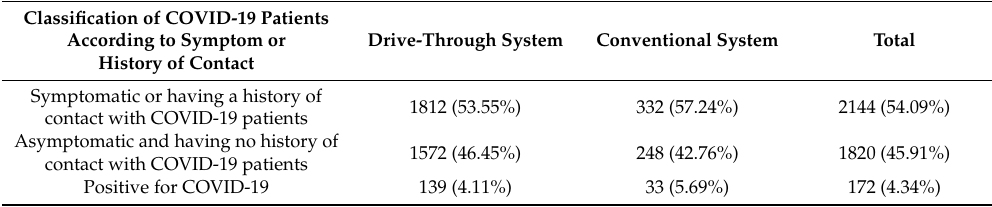
Table 4. The number of SARS-CoV-2-positive cases and positive rates based on the presence of symptoms and history of contact with COVID-19 patients according to the screening